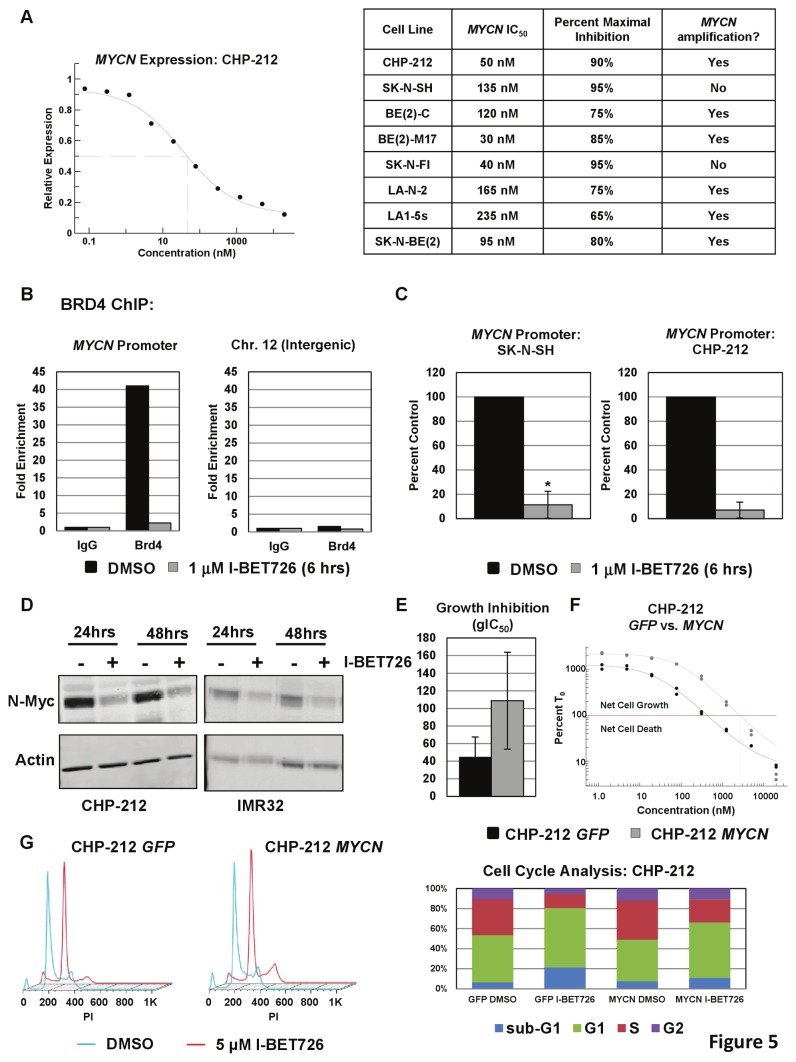

MYCN expression is directly regulated by BRD4 and repressed by treatment with I-BET726.(a) Left: Concentration response curve for MYCN RNA expression following 24 hour treatment with I-BET726 in the CHP-212 cell line. Data was normalized to GAPDH and is presented as expression relative to DMSO-treated controls. Data presented as the average of two independent curves from a single experiment, and is representative of data from three independent biological replicates. Right: Table of IC50 and percent inhibition values for MYCN suppression following 24 hour treatment with I-BET726 in the indicated cell lines. (b) BRD4 ChIP in the non-MYCN-amplified cell line SK–N–SH. Binding of BRD4 to the MYCN promoter or to an intergenic region on Chromosome 12 following treatment with vehicle or 1µM I-BET726 for six hours. Data is presented as fold enrichment over signal generated from IgG control immunoprecipitations. Data shown is from a single experiment representative of typical results. (c) BRD4 ChIP data at the MYCN promoter, presented as percent of vehicle control signal in the non-MYCN-amplified cell line SK–N–SH (left) and the MYCN-amplified cell line CHP-212 (right). SK–N–SH data represents the mean value ± standard deviation for three independent biological replicates. Asterisk indicates statistical significance as measured by t-test (p= 0.005). CHP-212 data represents the mean value ± standard deviation for two independent biological replicates. (d) Western blot analysis of N-Myc expression in the MYCN-amplified cell lines CHP-212 and IMR32 following 24 or 48 hour treatment with vehicle or 1µM I-BET726. Actin expression included as a loading control. (e) gIC50 values obtained from CHP-212 cells overexpressing GFP or MYCN following treatment with I-BET726 in a 6 day growth-death assay. Data represents the mean value ± standard deviation from four independent experiments. (f) Concentration response curves for GFP or MYCN–overexpressing CHP-212 cells from a 6 day growth-death assay. Horizontal line indicates T0 measurement (normalized to 100%). Data shown was from a single experiment representative of typical results. (g) Left: Histograms generated from cell cycle analysis in GFP- or MYCN-overexpressing CHP-212 cells following 4 days treatment with 5 µM I-BET726. Right: Percentage of cells in subs G1, G1, S, and G2 phases from the cell cycle experiment.